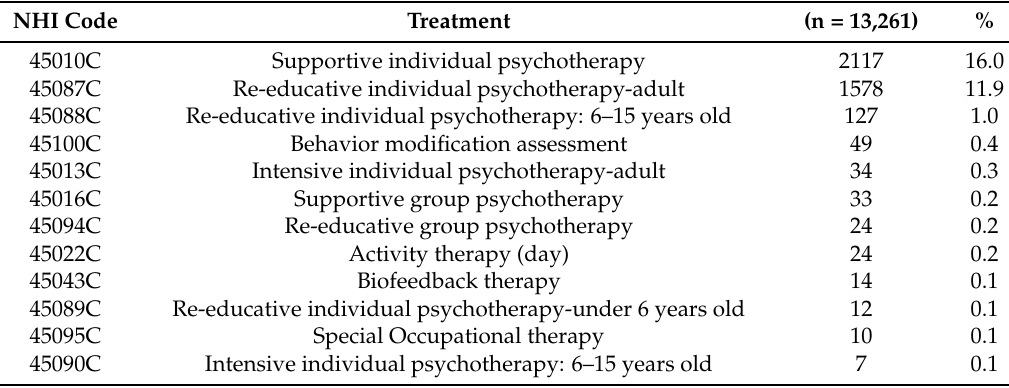
Table 2. Numbers and percent distributions of nonpharmacological